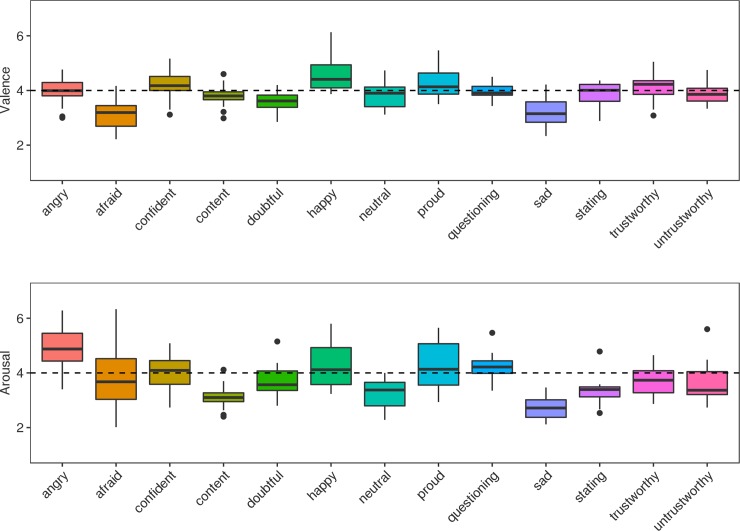
Box and whisker plots illustrating perceived valence (top) and perceived arousal (bottom) for each expression for a by-item analysis that used data points for each speaker and expression averaged across listeners and sentences.Black dashed lines indicate the rating scale midpoint.